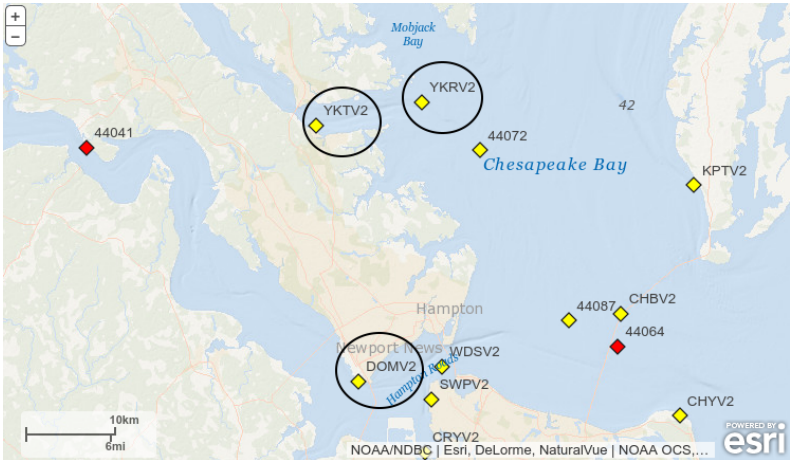
Figure 2. Geolocation of the NDBC meteorological stations in Virginia (USA)